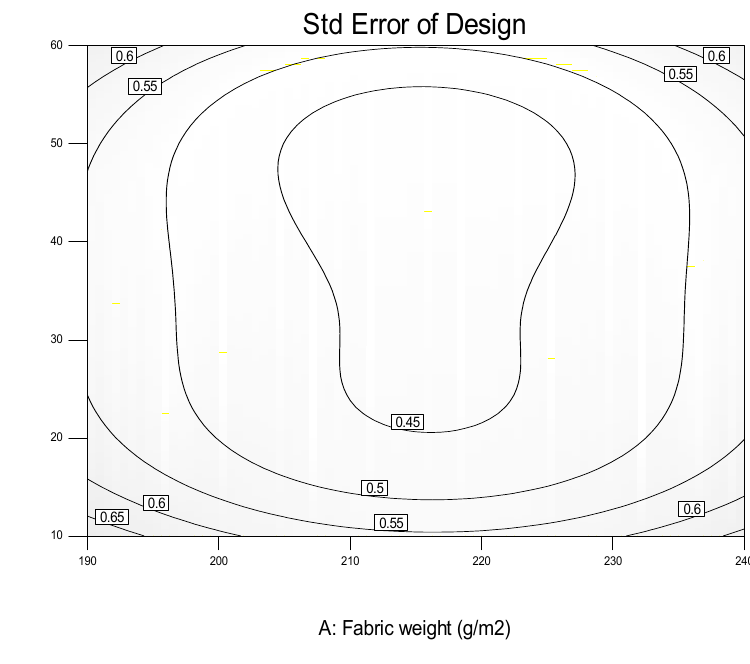
Figure 3. Standard error of design.